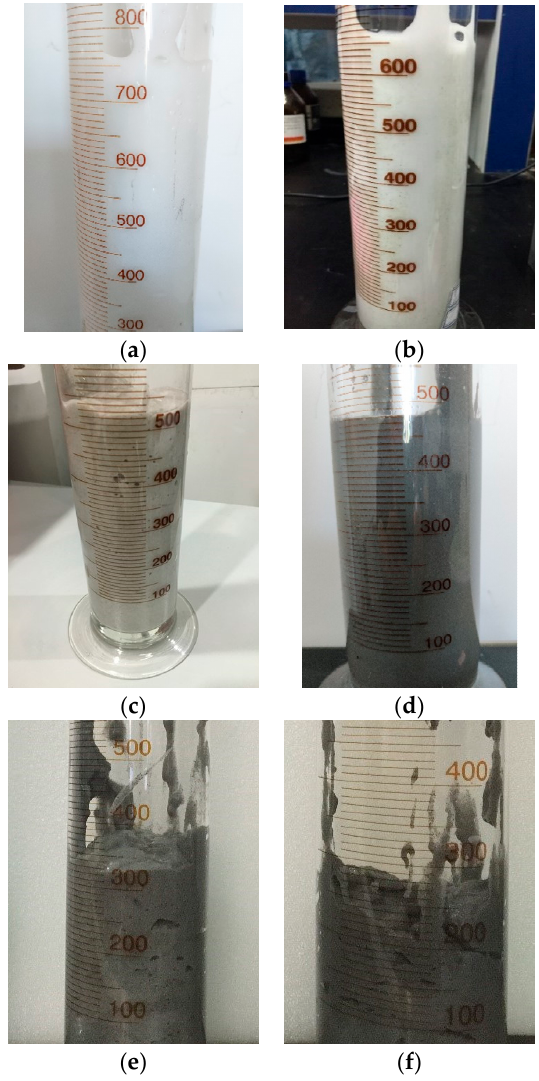
Figure 3. Images of the generated foam under various consolidation concentrations: ( a ) 0%; ( b ) 0.5%; ( c ) 5 %; ( d ) 10%; ( e ) 20%; ( f ) 30%.